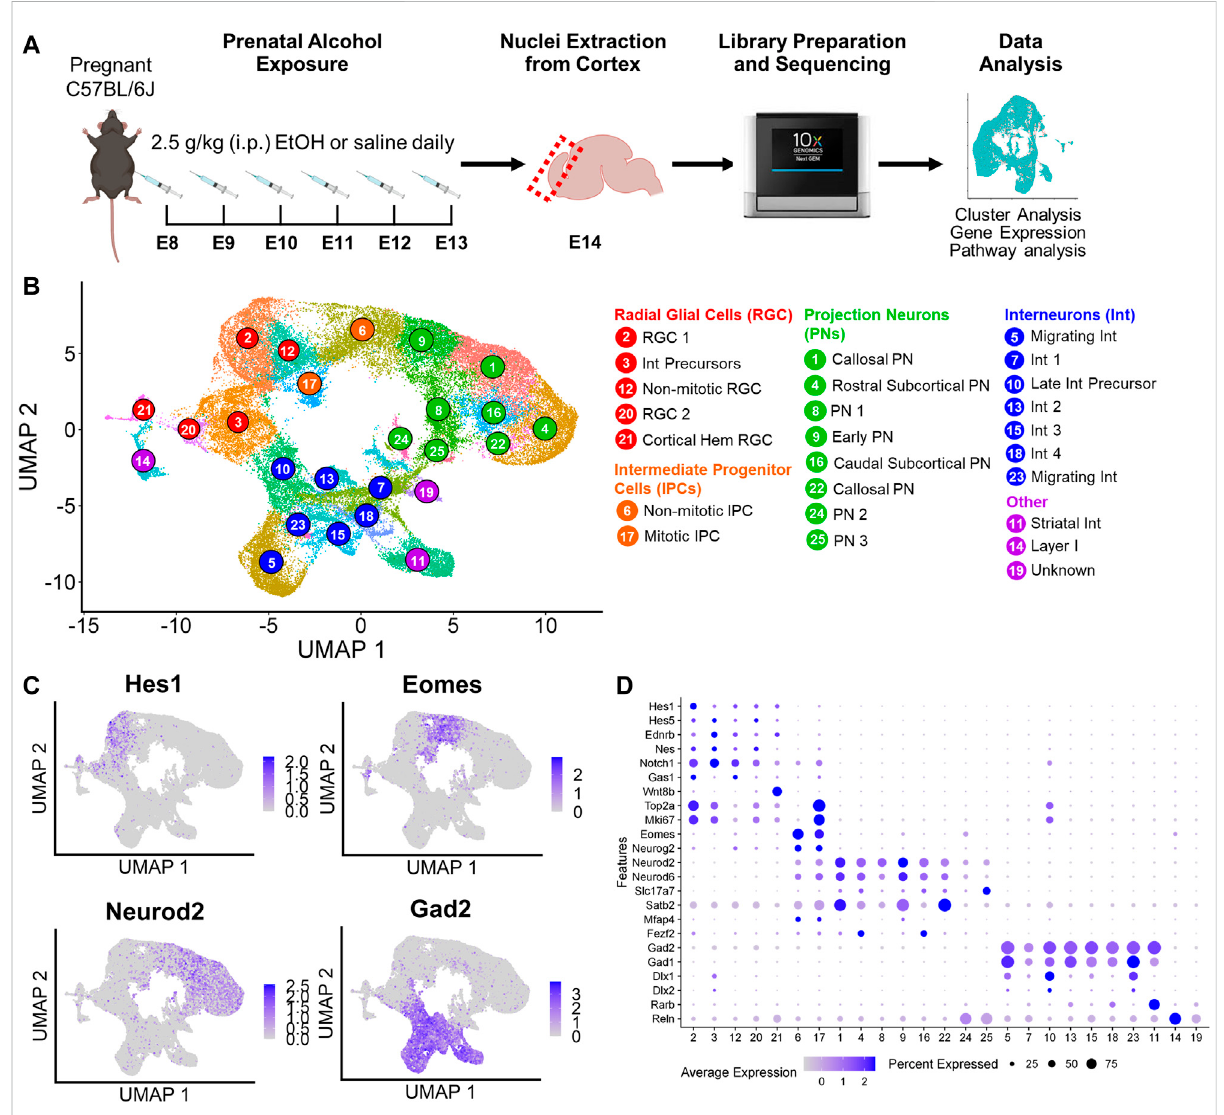
FIGURE 1 Experimental design and cluster identi fi cation. (A) Schematic of the prenatal alcohol exposure (PAE) paradigm. The icons used were obtained from BioRender.com. (B) Uniform Manifold Approximation and Projection (UMAP) visualization of the 25 clusters identi fi ed. (C) UMAPs overlaid with gene expression of canonical cell type markers ( Hes1 : radial glial cells; Eomes : intermediate progenitor cells; Neurod2 : projection neurons; Gad2 : interneurons). (D) Dot plot representation of the average expression and percentage of cells expressing markers of cluster cell types. Darker dots indicate higher gene expression, and larger dot sizes indicates higher percentage of cells expressing the